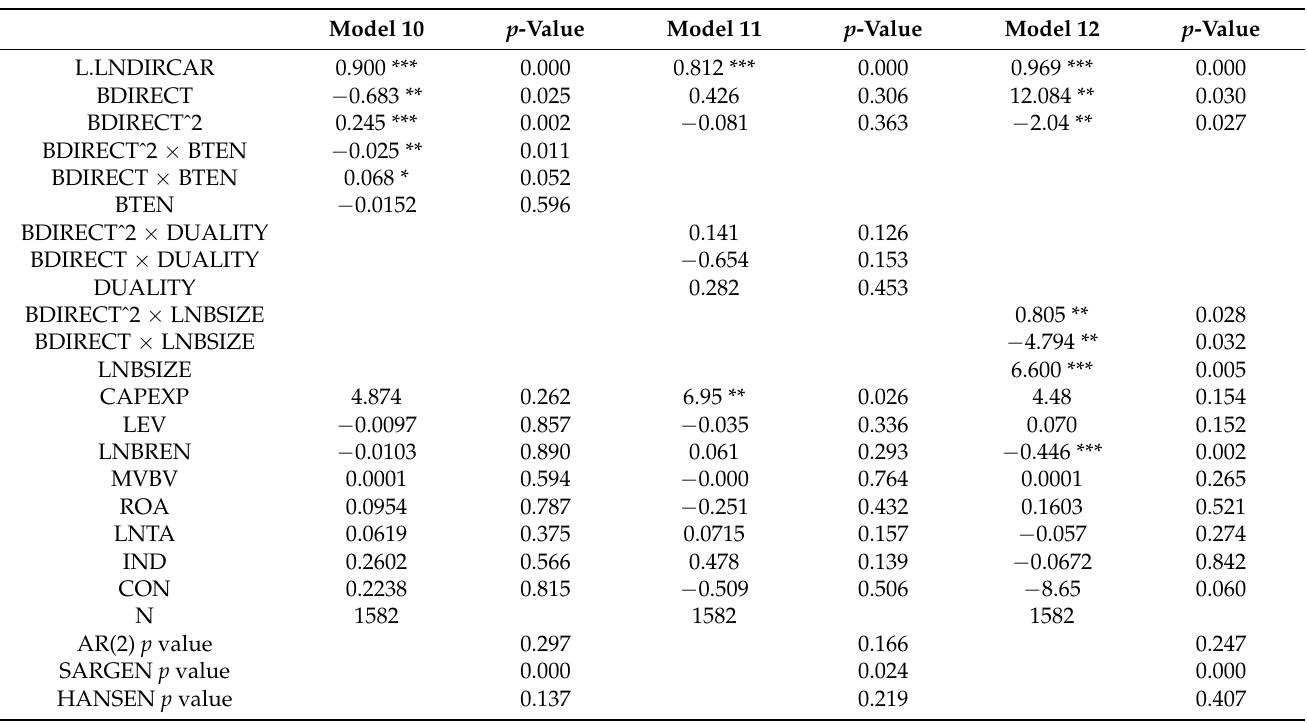
Table 9. Robust tests: Models 10, 11, and